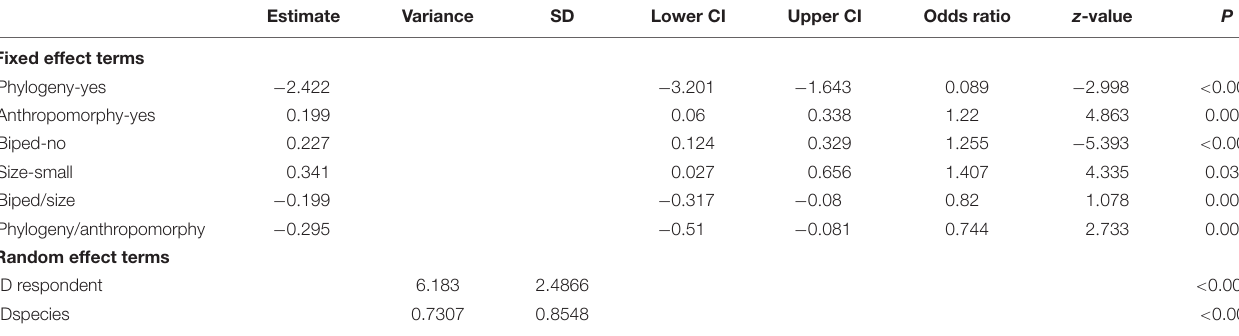
TABLE 5 | Results of the cumulative link mixed model on the respondent’s willing to protection ratings. Estimate Variance